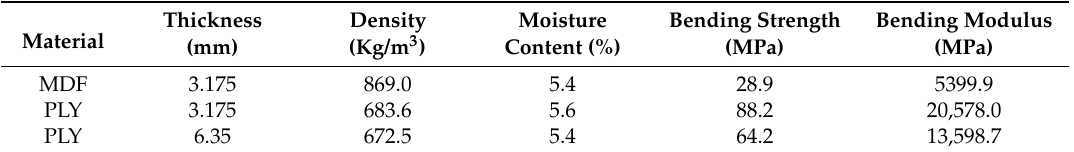
Table 1. Properties of the medium density fiber board (MDF) and plywood (PLY) used in the outer layers